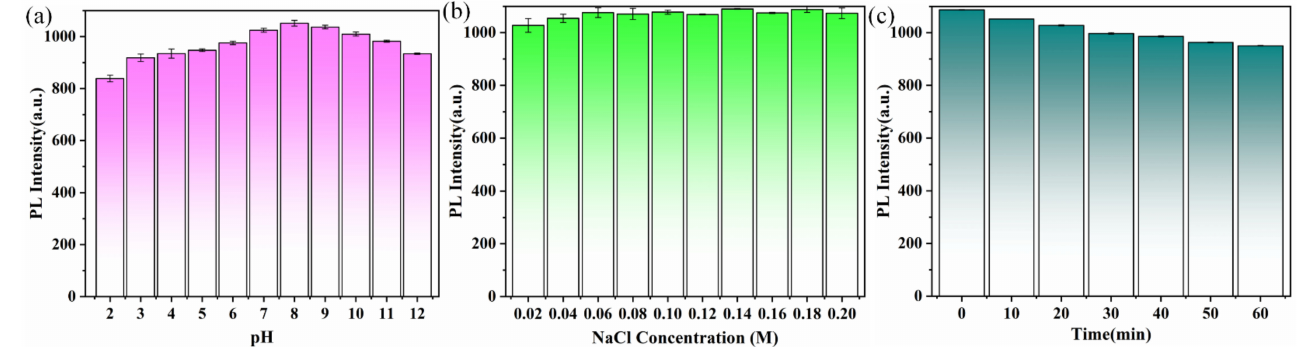
Figure 5. ( a ) Stability of fluorescence intensity of the wh-CQDs at different pH values, ( b ) NaCl concentrations, ( c ) exposure to UV light (0–60